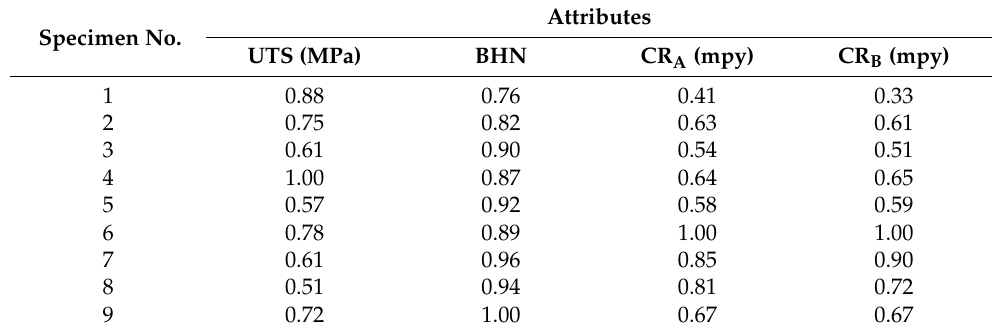
Table 9 indicates normalized decision matrix. Table 9. Normalized decision matrix.